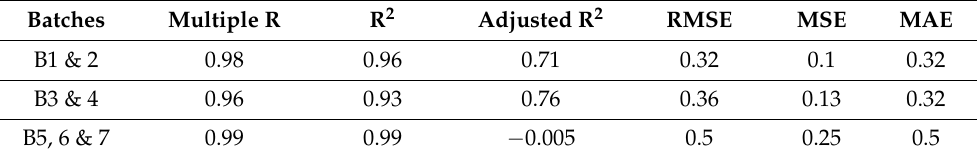
Figure 12. Actual vs. Predicted Concrete Split Tensile Strength Values with Testing Dataset. Table 9. Split Tensile Strength Results of ANN